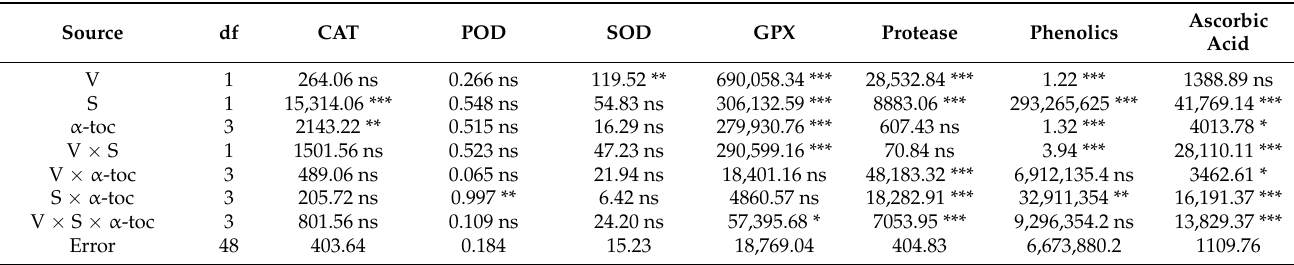
Table 1. Analysis of variance (mean squares) for enzymatic and non-enzymatic antioxidants traits of okra treated with α -Toc as foliar spray under saline and non-saline conditions.